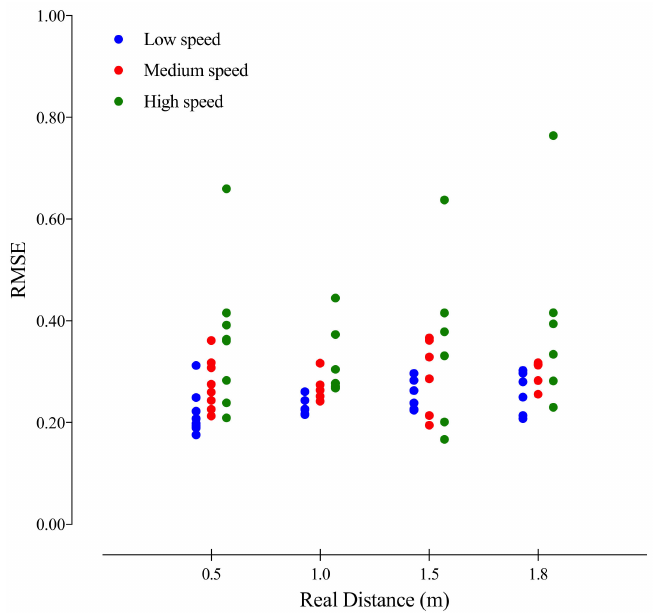
Figure 5. Inter-tag accuracy and the respective predetermined distances between